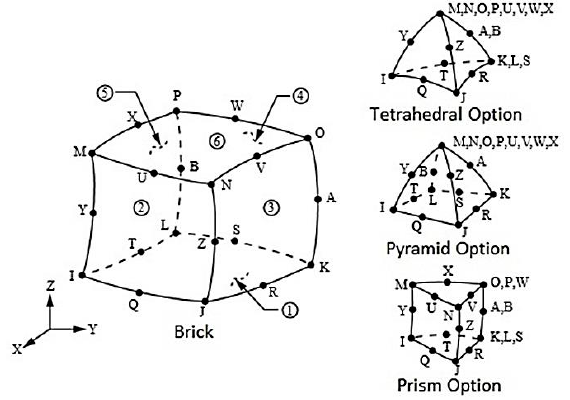
Figure 6. Solid186 element in Ansys and its variations according to [23].